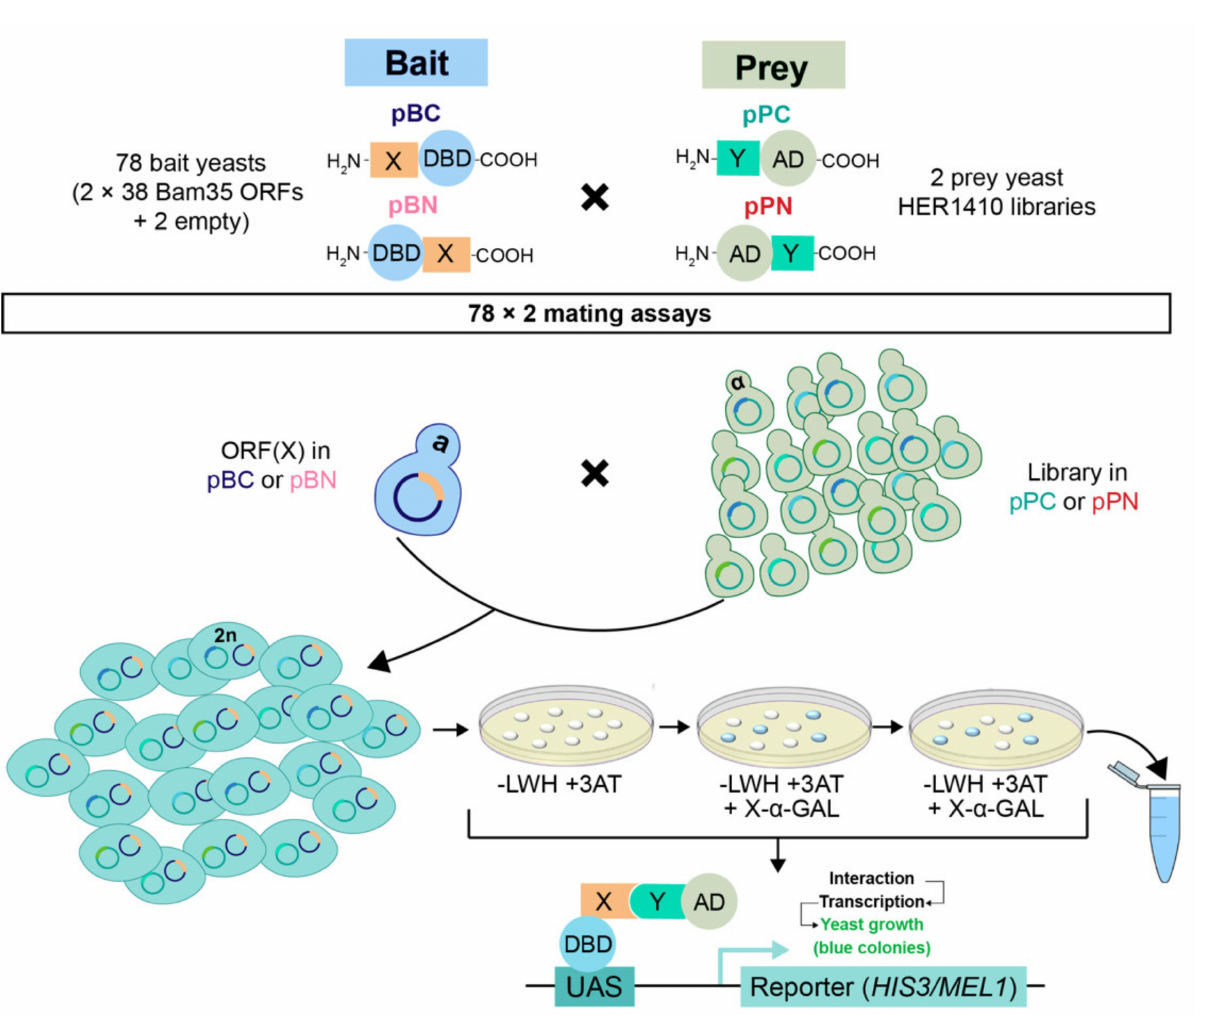
Figure 3. Bam35– B. thuringiensis Y2H interactome screening. Schematic representation of the Y2H assays. A total of 156 Y2H experiments were performed to test the interactions between each of the ORFs of Bam35 (X) that were cloned into bait vectors (C- and N-terminal fusion) and the generated HER1410 libraries (Y) that were cloned into prey vectors (C- and N-terminal fusion). For each assay, a Bam35 ORF-containing bait yeast was mated with one of the HER1410 library-containing prey yeast. Positive interactions were detected using HIS3 and MEL1 markers. Mated cells were plated on selective solid media without leucine, tryptophan, or histidine (-LWH); supplemented with the corresponding 3AT concentration; and then replicated twice in -LWH +3AT plates supplemented with X- α -Gal. The cells that were able to express the HIS3 gene grew on -LWH plates and, further, those that were able to express MEL1 turned blue in presence of X- α -Gal. All cells of the last replica were pooled and harvested for further